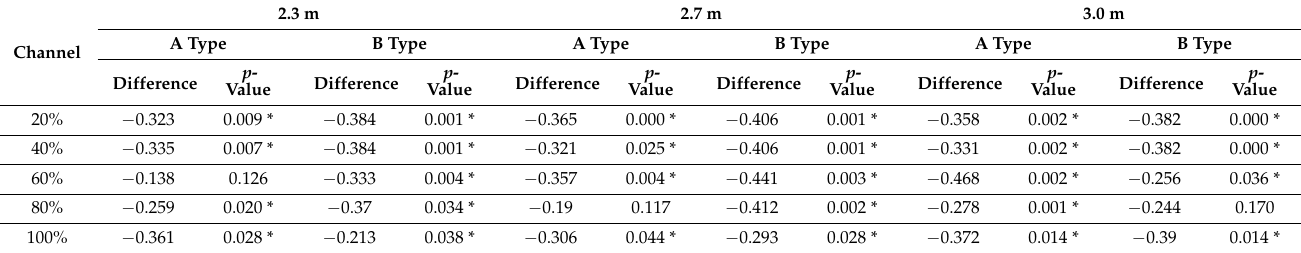
Table 4. Analysis of the difference in RAB indicator values between ceiling height and aspect ratio (A/B).